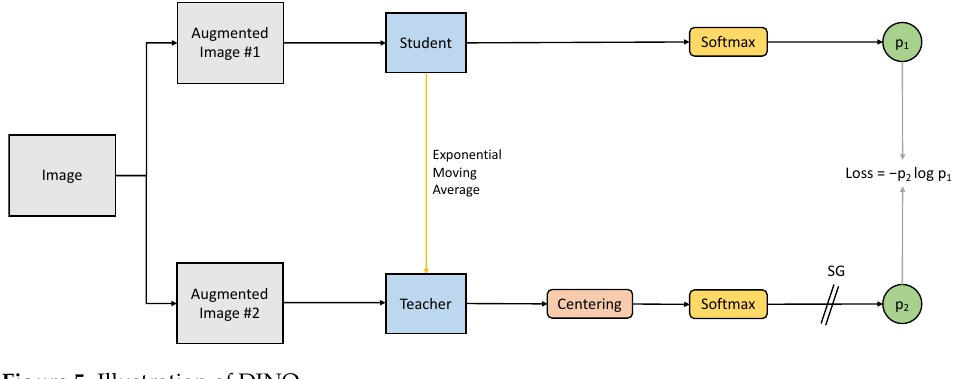
Figure 5. Illustration of DINO.